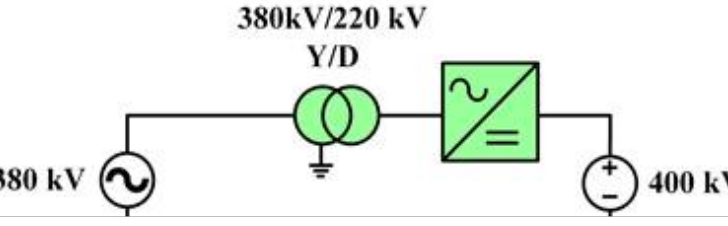
Figure 3. Test circuit for model validation. Table 1. Parameters of the test system from Figure